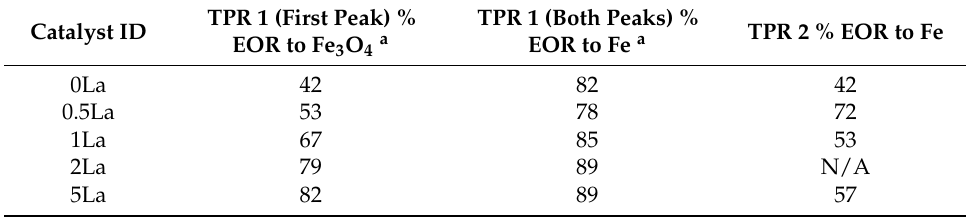
Table 1. Extent of reduction of catalysts for TPR 1 and TPR 2 (10 mol % H 2 /Ar, total flow = 50